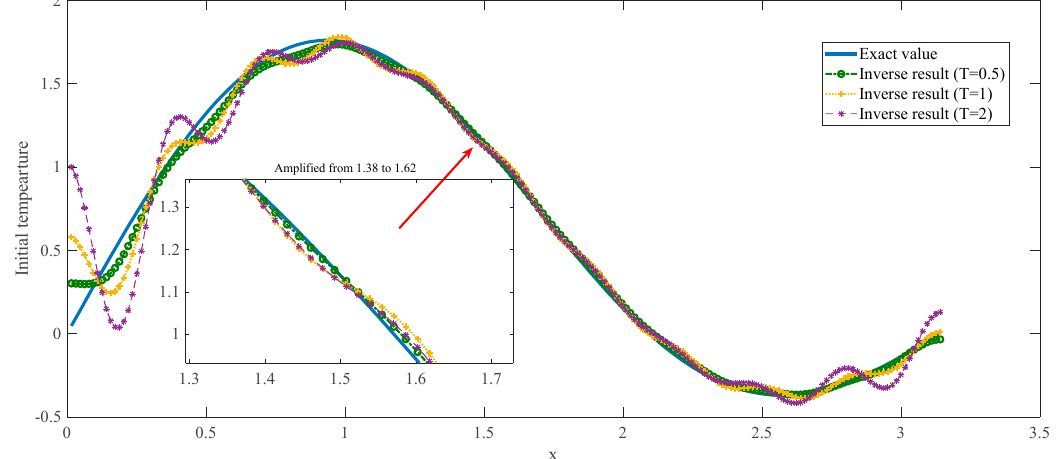
( x ,0 ) from exact u ( x , T ) with di ff erent T Figure 3. Recovery of ( 0) u x, from exact ( ) u x,T with different T . Figure 3. Recovery of u